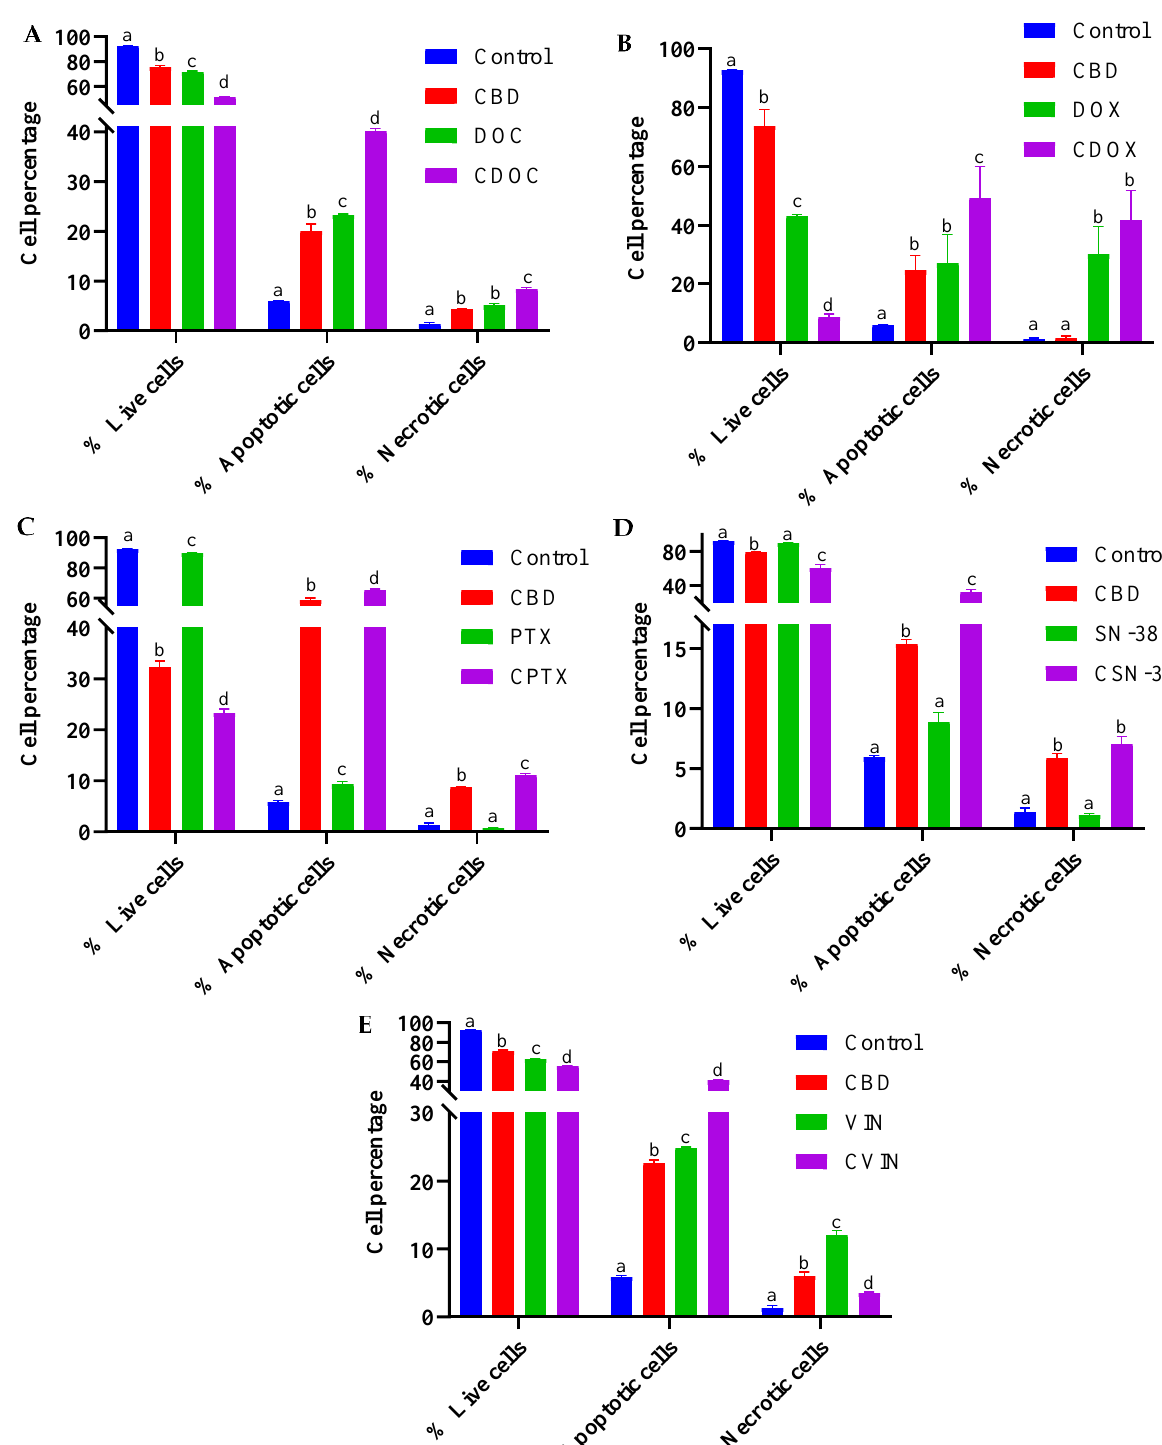
Figure 5. Cell percentage analysis of MCF7 cells after 24 h of treatment with cannabidiol, chemotherapeutic drugs, and their synergistic combinations ( A-E ). CBD = cannabidiol: DOC = docetaxel: DOX = doxorubicin: PTX = paclitaxel: SN − 38: VIN = vinorelbine. ( A ) CDOC = CBD (39.75 µ M) + DOC (0.5 µ M), ( B ) CDOX = CBD (38.42 µ M) + DOX (0.2 µ M), ( C ) CPTX = CBD (64.60 µ M) + PTX (0.1 µ M), ( D ) CSN − 38 = CBD (42.45 µ M) + SN − 38 (0.11 µ M), ( E ) CVIN = CBD (42.4 µ M) + VIN (0.1 µ M). Superscript letters indicate statistical significance derived from two-way ANOVA and Tukey’s multiple comparisons within the same cell group, where different letters are statistically significant at p < 0.05 ( n = 3). Raw data are available in Table